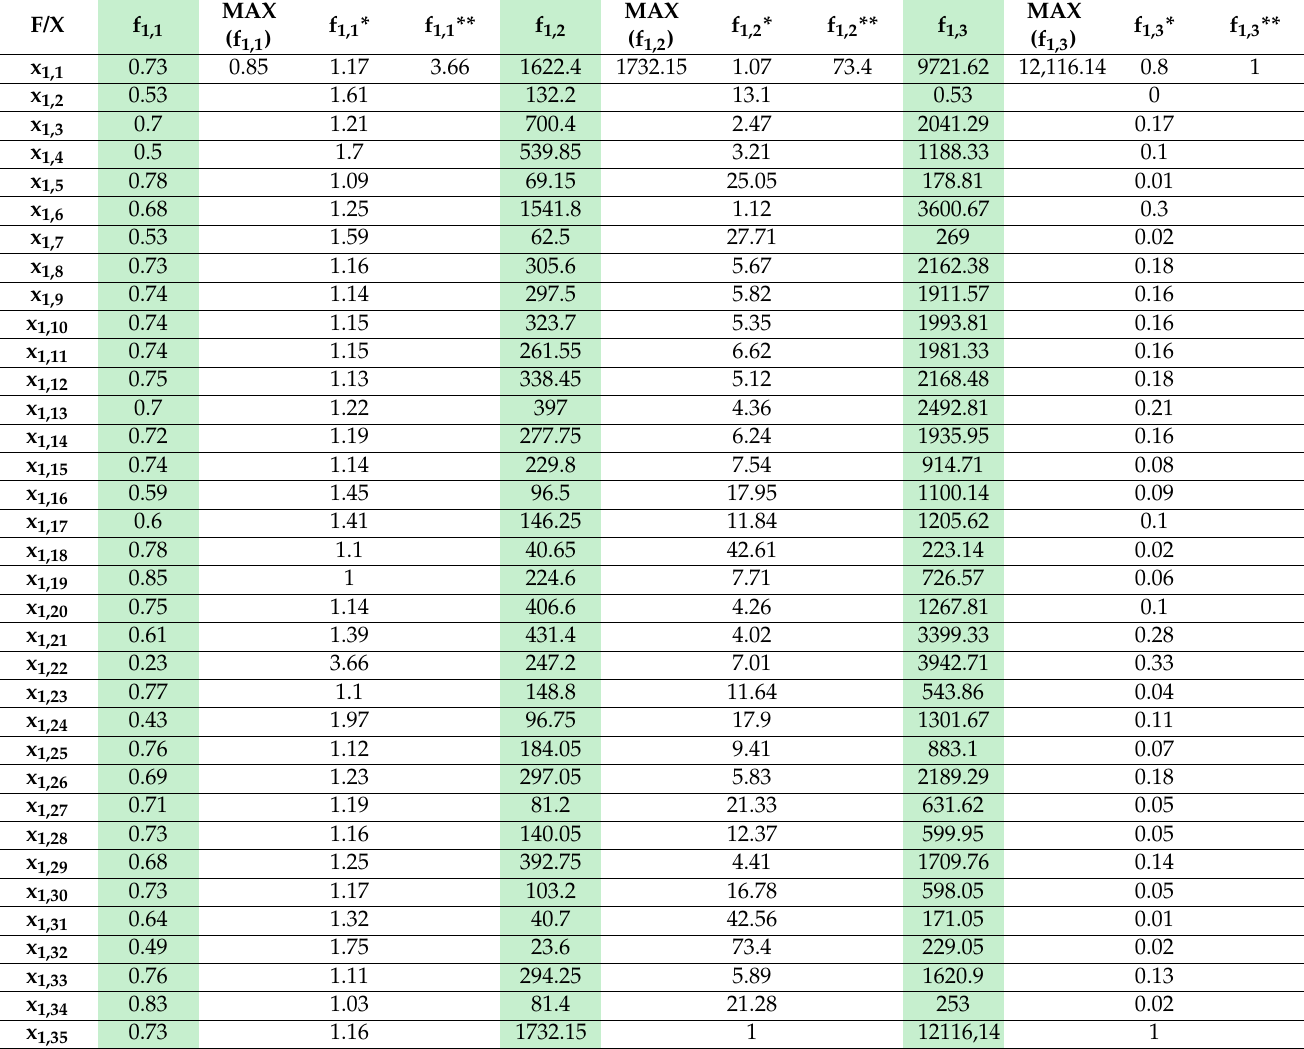
Table 2. Visualization of the results of solving the optimization task.